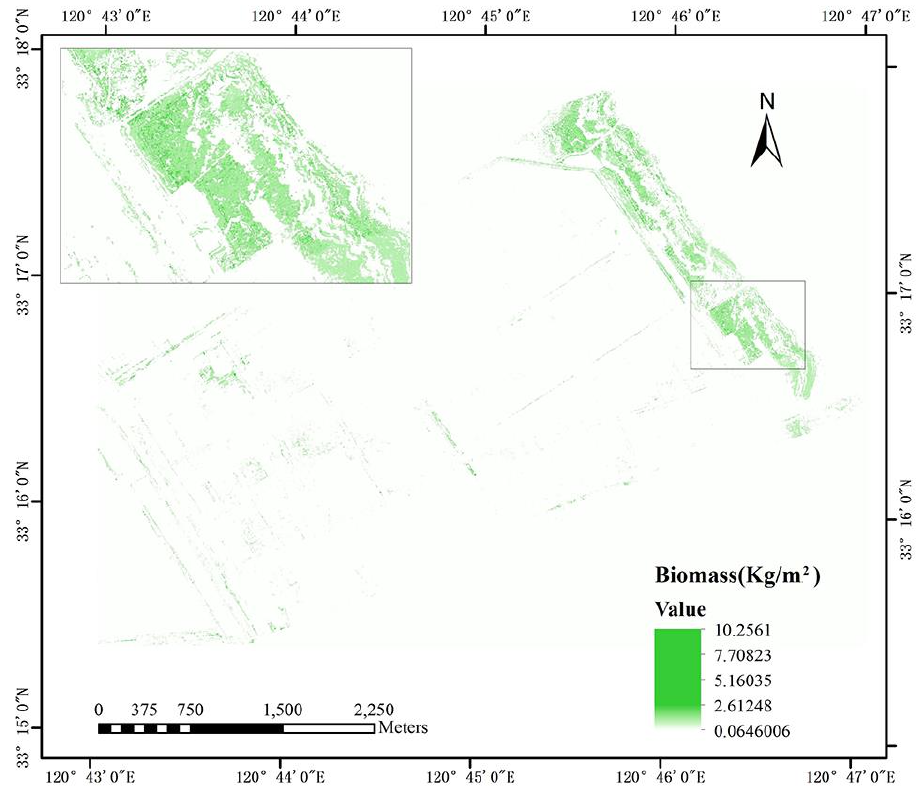
Figure 6. Mapping biomass content of S. alterniflora using LiDAR data and hyperspectral images.